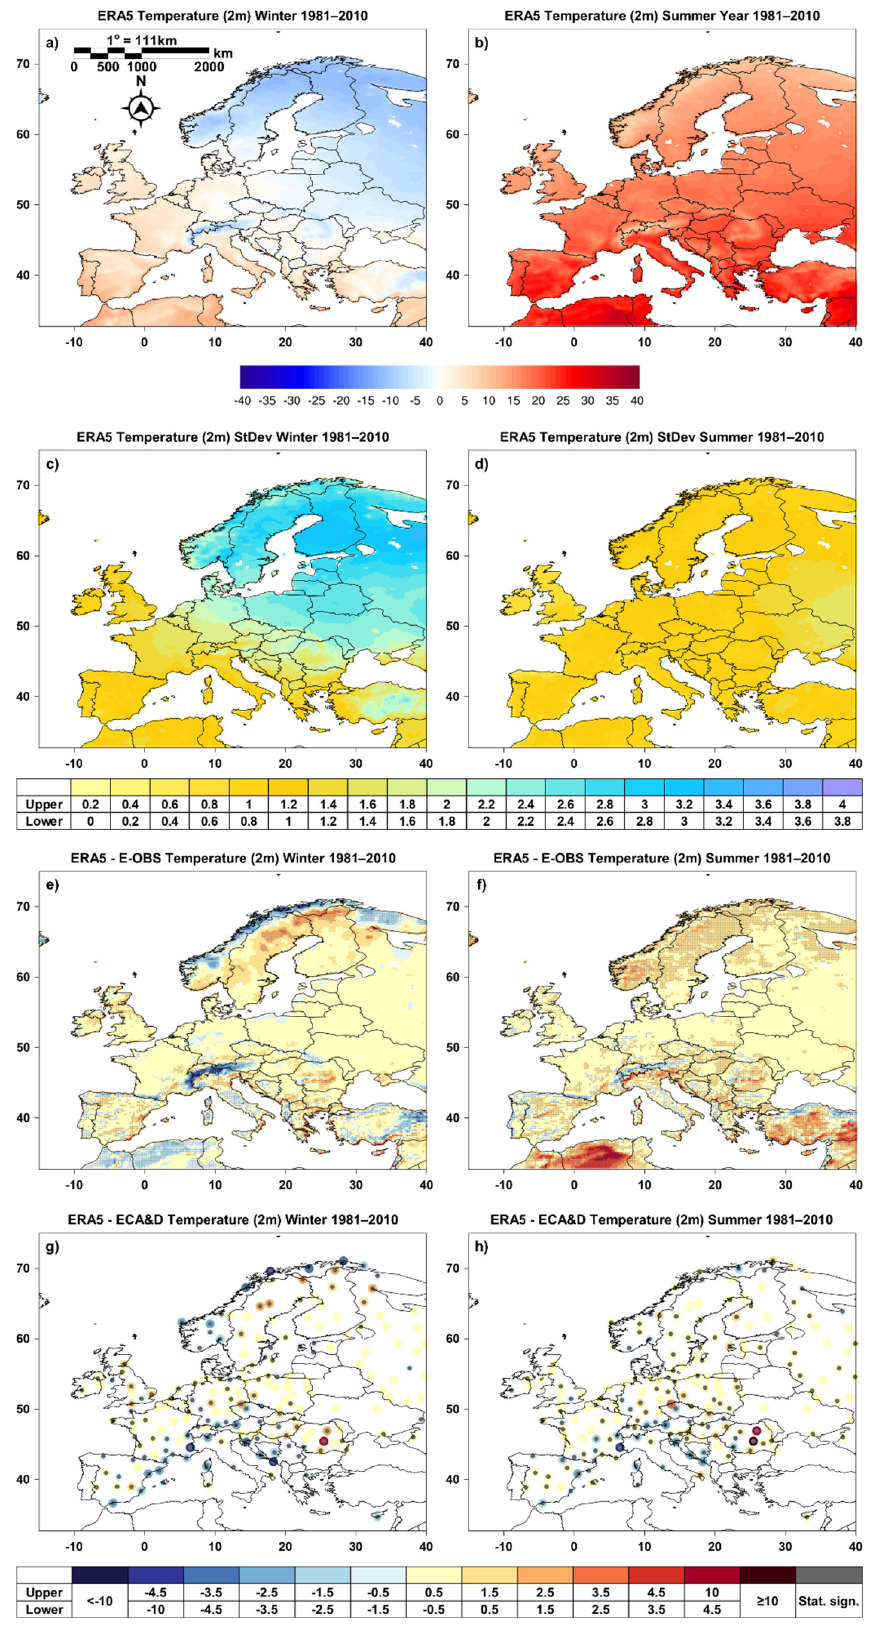
Figure 4. ( a , b ) Mean temperature (°C) and ( c , d ) standard deviation for ERA5, and the differences between ( e , f ) ERA5 and E-OBS, and ( g , h ) ERA5 and ECA&D stations during winter (left) and summer (right).